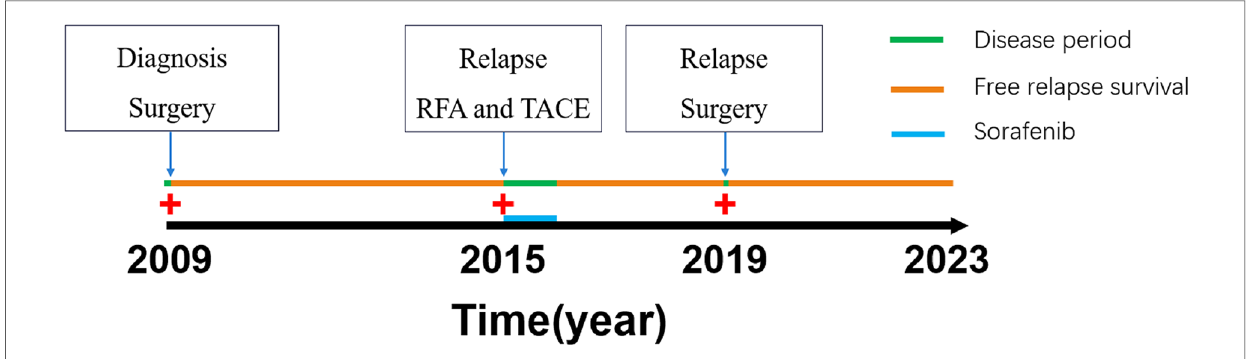
FIGURE 1 The timeline of patient ’ s